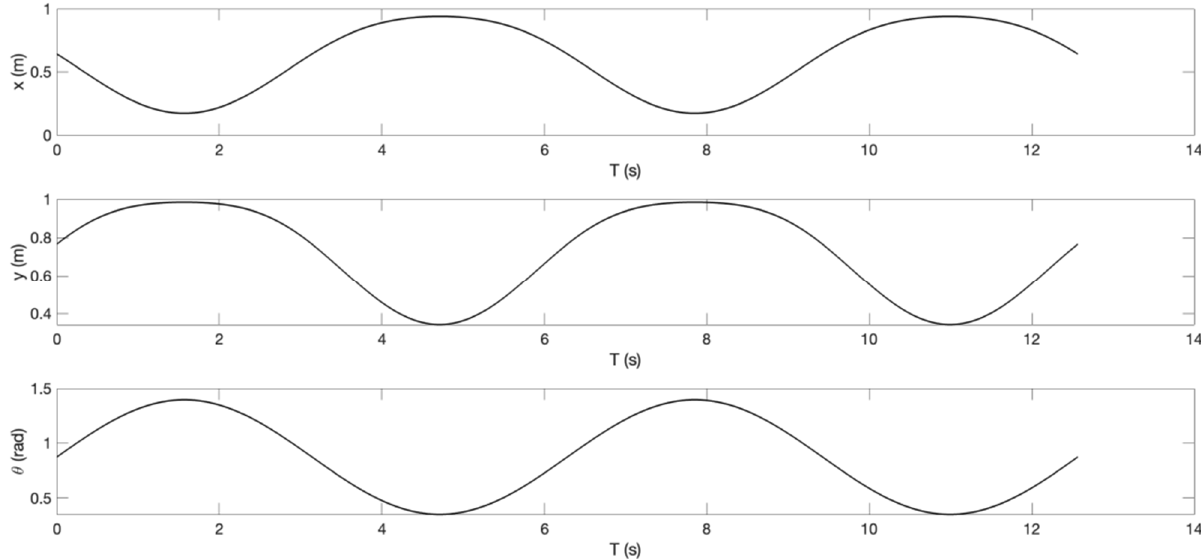
Figure 16. The Cartesian reference trajectory for the backrest motion projected on the x -axis and y - axis.